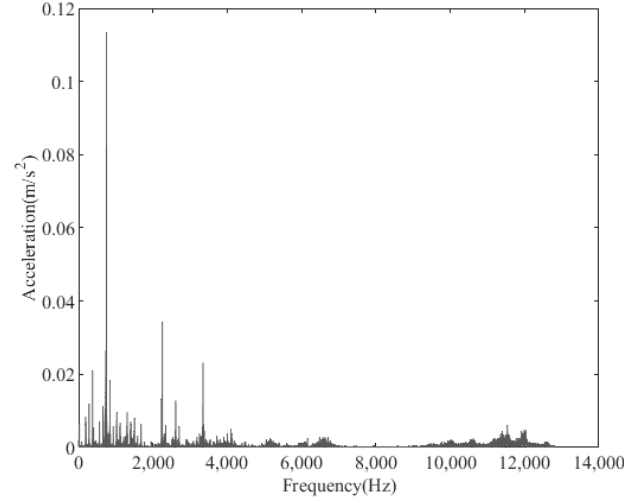
Figure 37. Acceleration spectrum (slight friction). Figure 37. The amplitude spectrum of the test signal (slight friction).